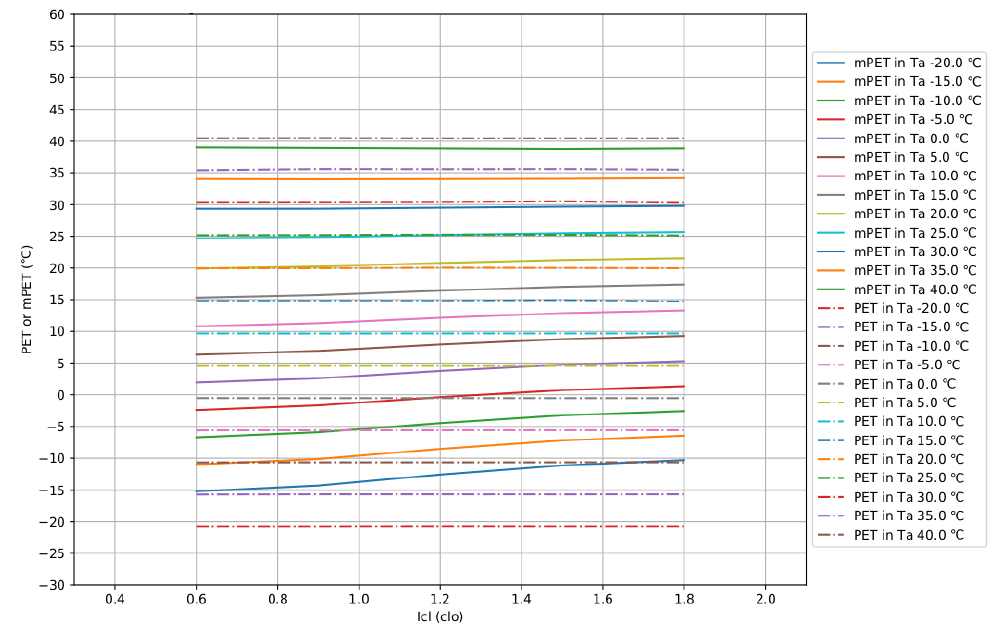
Figure 9. The comparison of PET and mPET in different T a and Icl